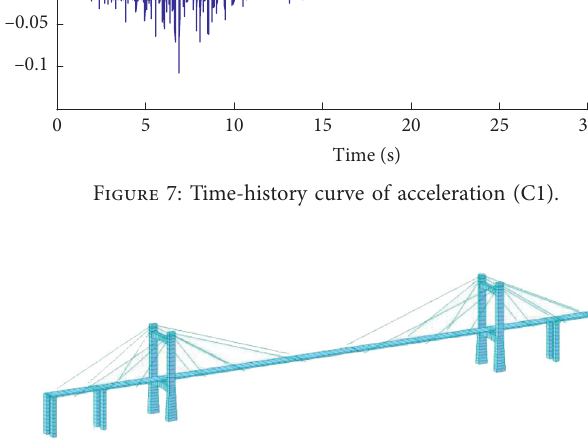
Figure 8: Bridge model